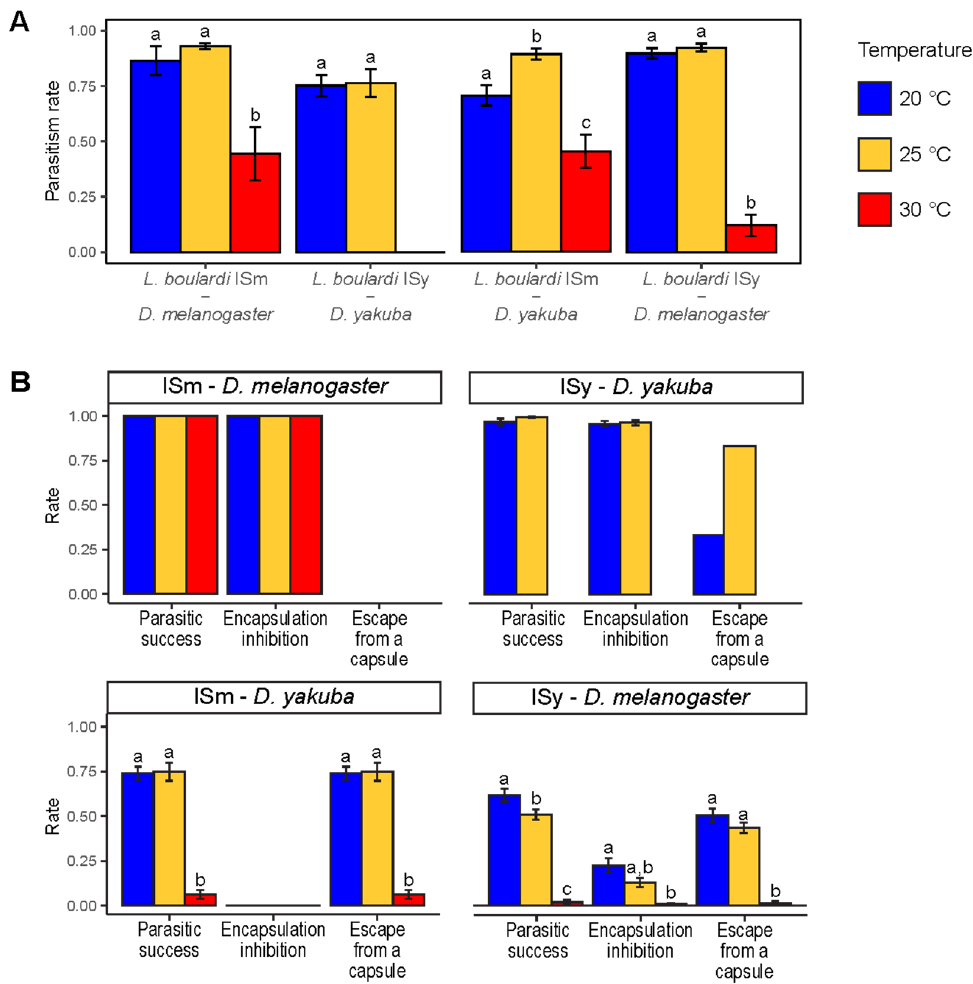
Figure 4. Impact of temperature during parasitoid nymphal development on the outcome of host– parasitoid interaction. ( A ) Parasitism rates for the four host–parasitoid interactions as a function of temperature. ( B ) Rate of (i) parasitic success, (ii) parasitoid capacity to inhibit encapsulation by the host and (iii) parasitoid capacity to escape from a capsule, depending on the temperature. Within each host—parasitoid interaction, different letters indicate a significant difference between temperatures for a given parameter. Bars indicate standard errors. There are no error bars for the parasitoid capacity to escape from a capsule for the ISy— D. yakuba interaction at 20 °C et 25 °C because only one and two host larvae contained a capsule, respectively, and it was an open capsule (see Supplementary Tables S3 and S4 for sample sizes and statistical outputs).